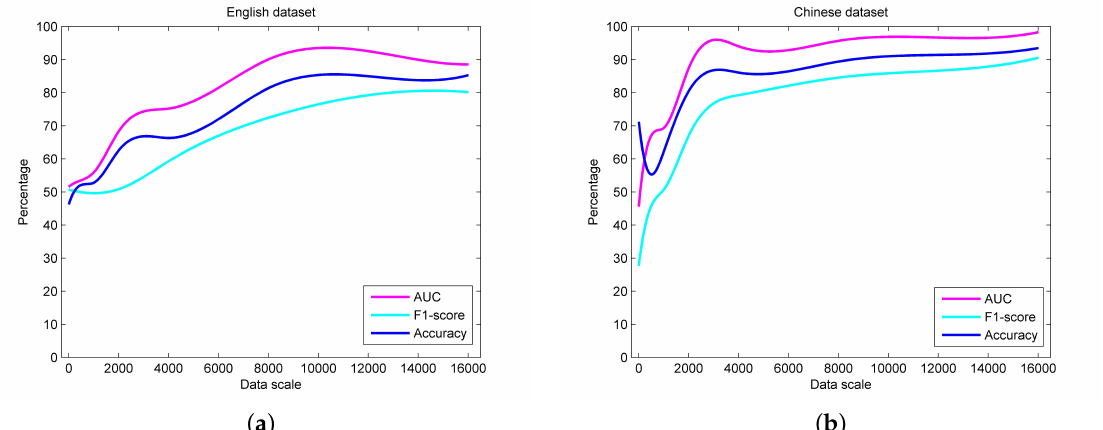
Figure 9. Performance of the proposed model with different data set scales. ( a ) English dataset. ( b ) Chinese dataset.